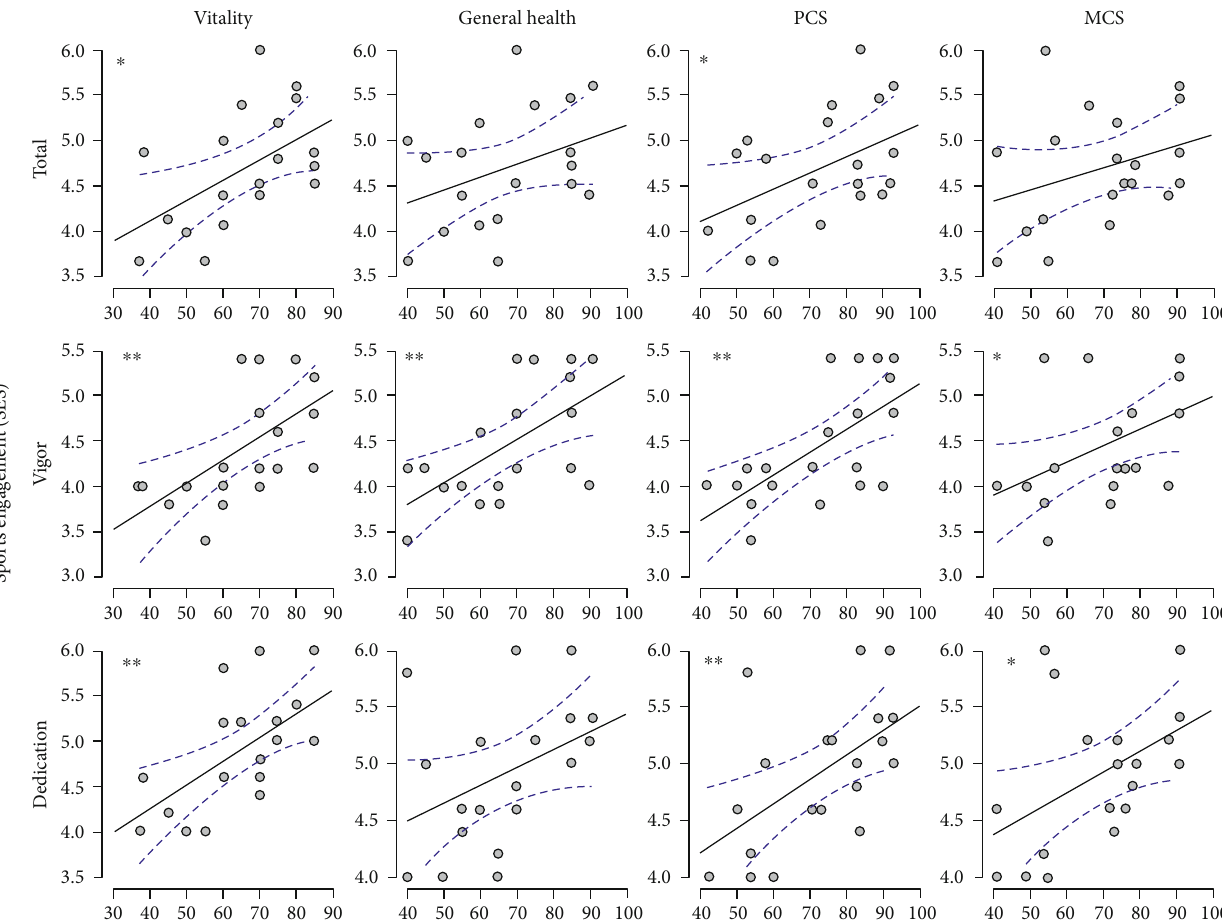
Figure 5: Pearson ’ s correlation scatterplot between subscales of SES and SF-36. x -axis indicates SF-36 score; y -axis shows SES score. Dashed curves indicate lower and upper bounds of con fi dence interval. ∗ p < 0 : 05 ; ∗∗ p < 0 : 01